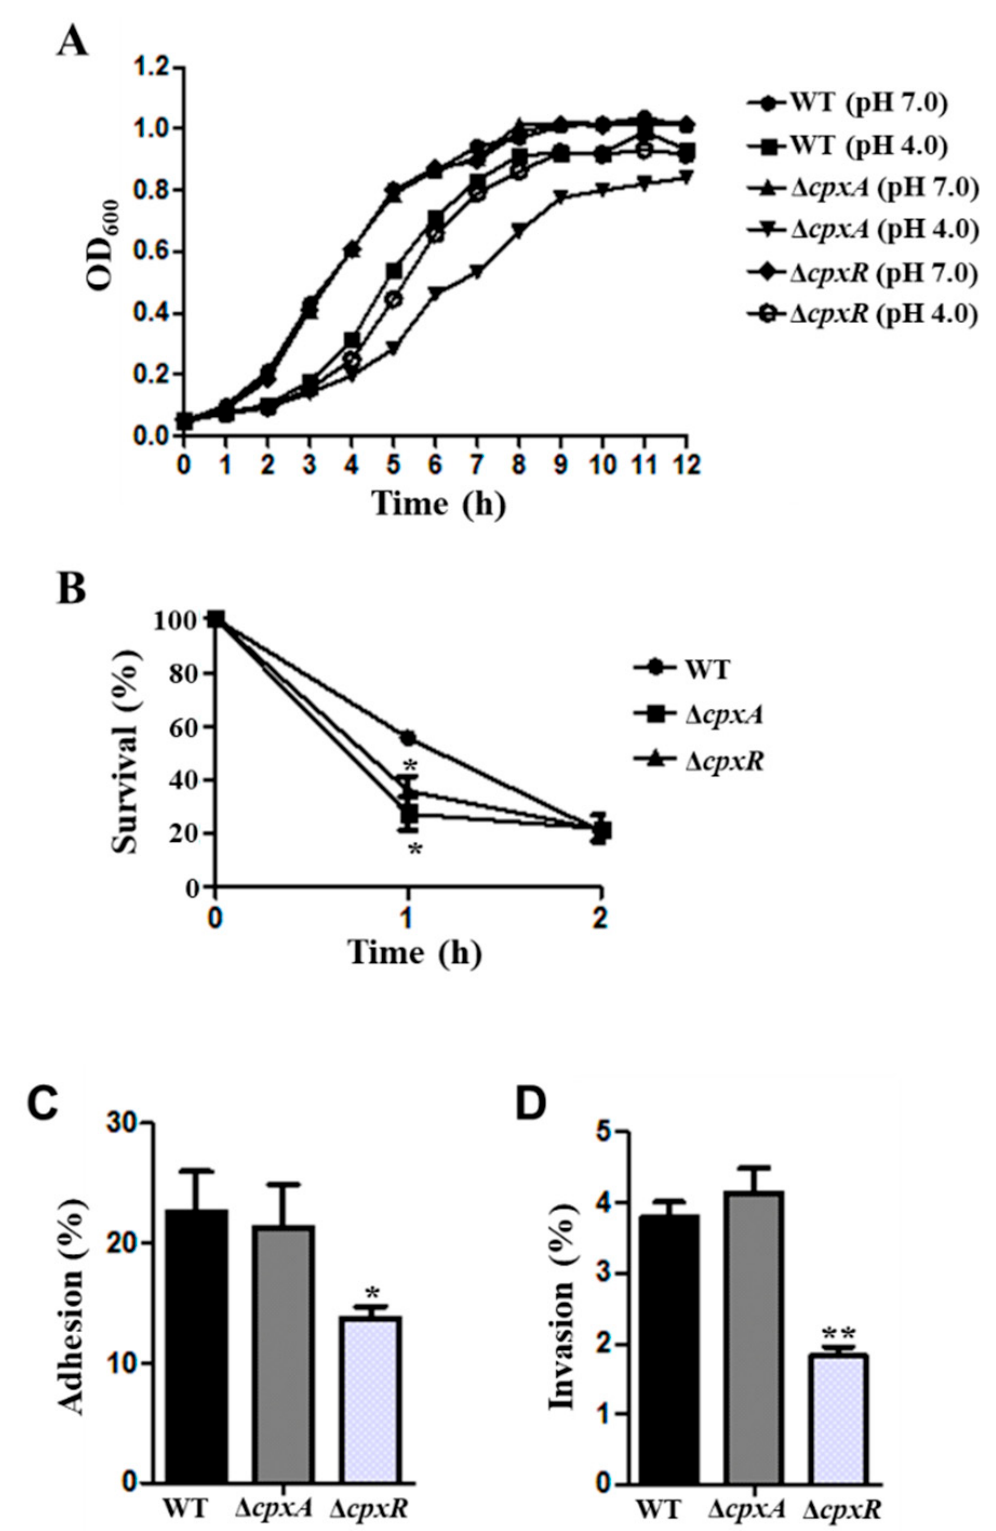
Figure 5. The function of CpxAR in acid resistance and virulence of S . Derby. ( A ) Growth curves of WT, ∆ cpxA and ∆ cpxR in LB mediums at pH 4.0 and pH 7.0. ( B ) Survival ability of WT, ∆ cpxA and ∆ cpxR at pH 4.0. Adhesion ( C ) and invasion ( D ) rate of WT, ∆ cpxA and ∆ cpxR after infection with the MC38 cells. All the experiments were repeated three times. *, p ≤ 0.05; **, p ≤ 0.01 (Student’s t -test).